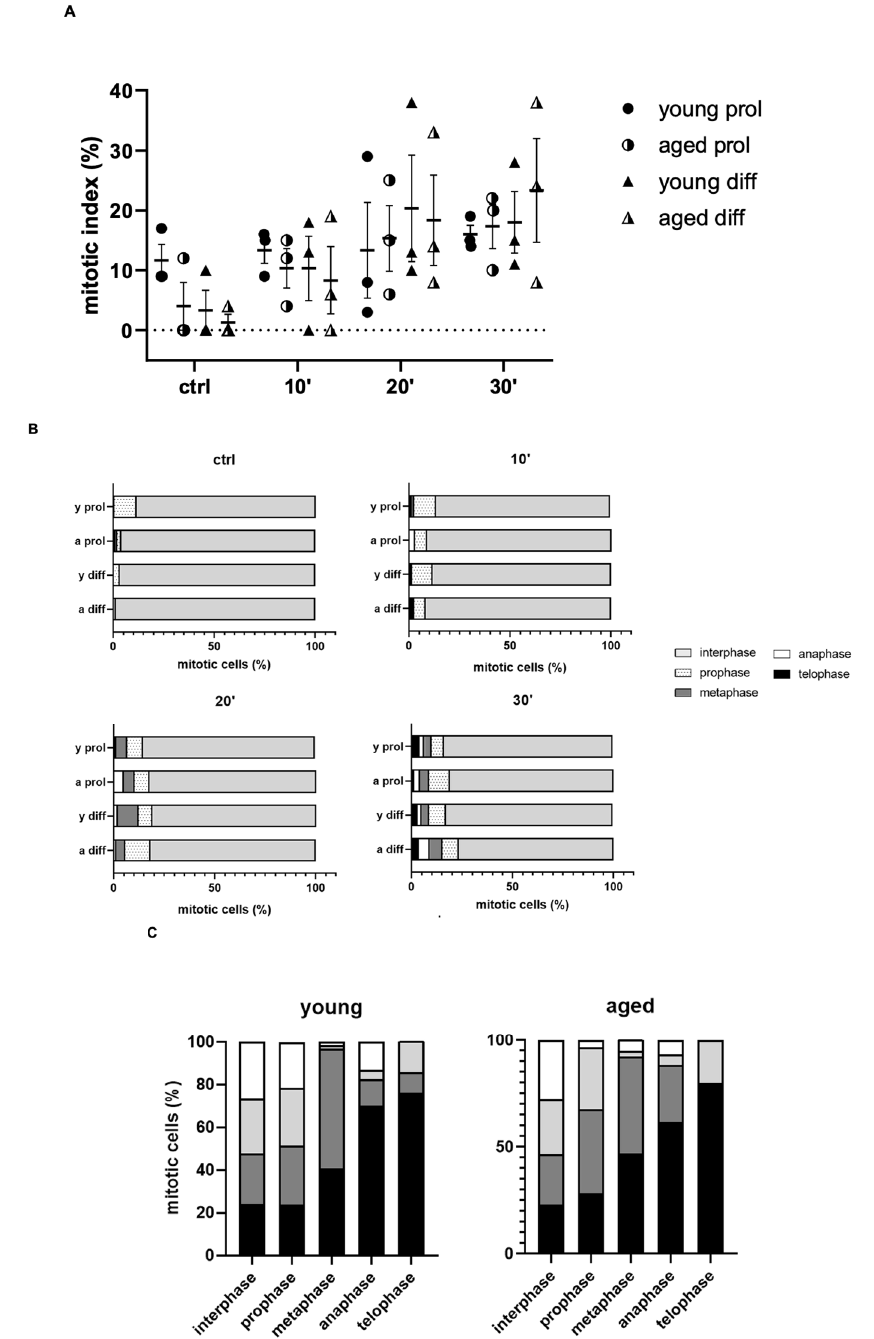
Figure 7. Effect of ViSS treatment on SC/myoblast proliferation. ( A ) Mitotic index (%). ( B ) Percent- ages of cells in the different mitotic phases. ( C ) Mitotic cell distribution in the different phases in young vs. aged samples. Data are expressed as mean ± SEM of three independent experiments ( n = 3). Mitotic index was scored out of a total of 39–41 cells for each experimental group.